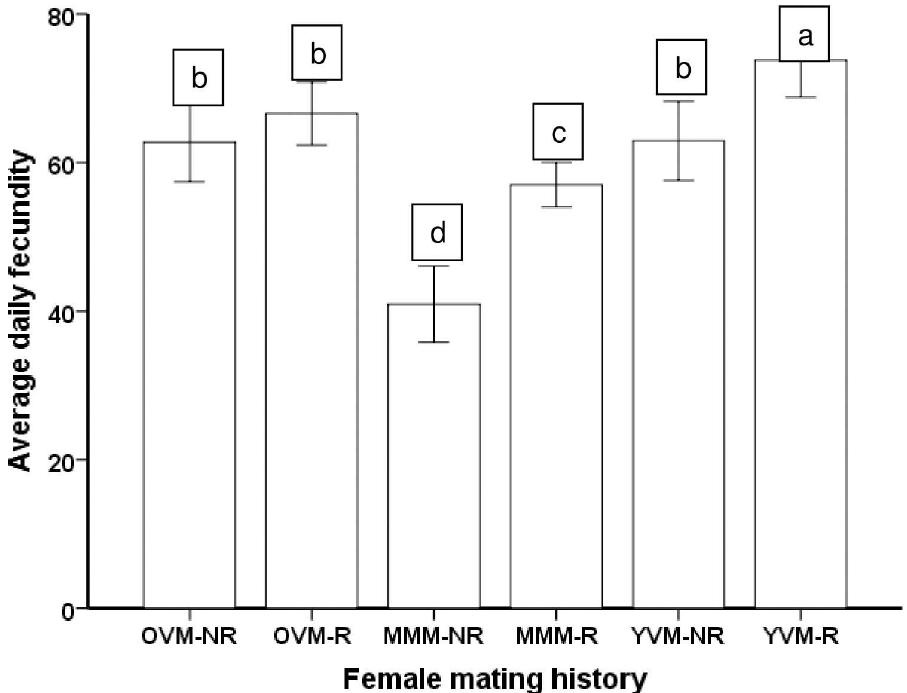
Fig 5. Average daily fecundity ( ± SE) for Ostrinia nubilalis females that mated first with a multiple mated male (MMM), an old (9 days old) virgin male (OVM) or a young virgin male (YVM), and then remated(R) or not (NR). Means with different letters are significantly different (Sidak Test, a = 0.05)